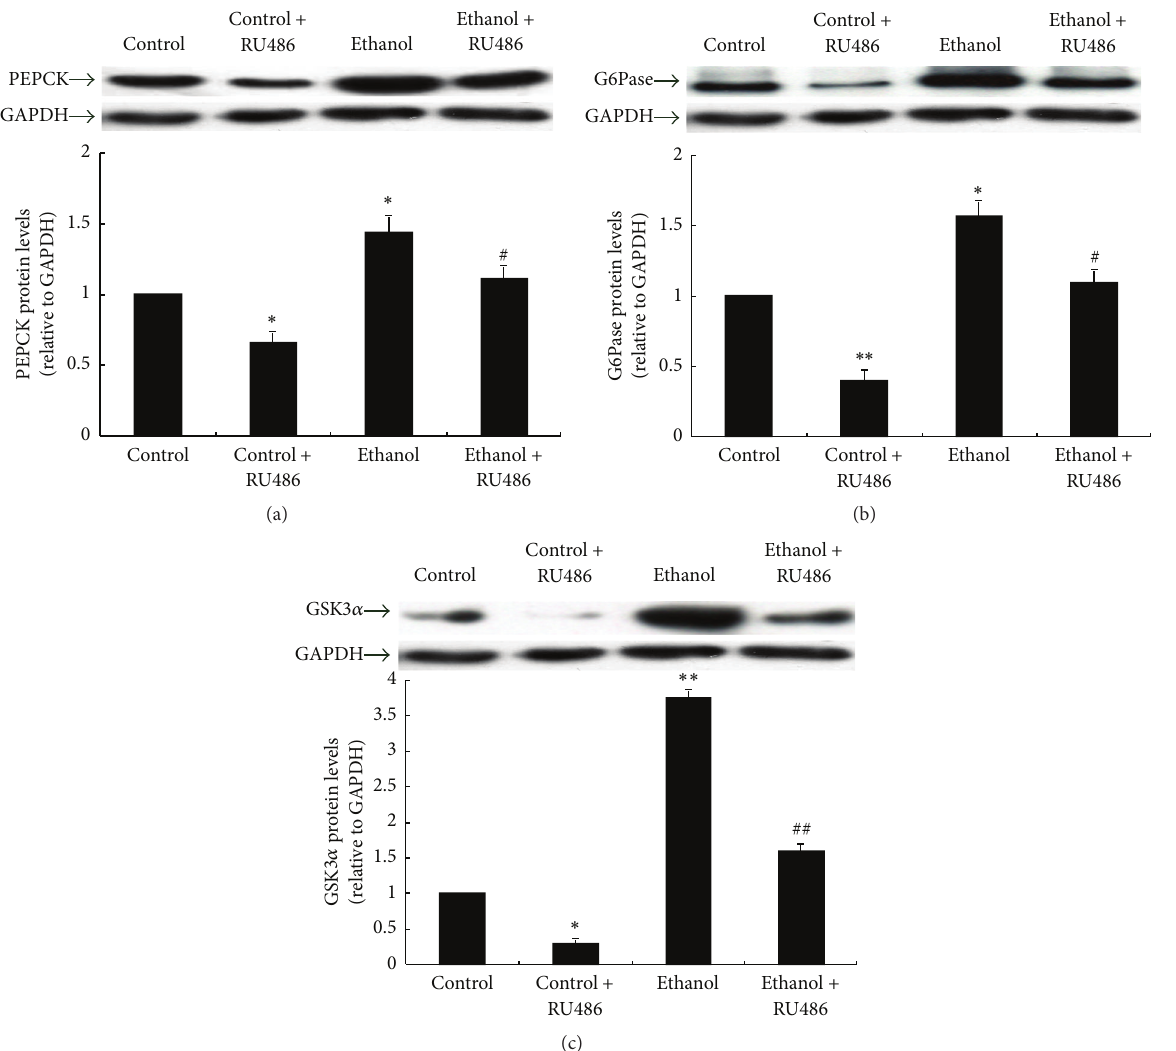
Figure 5: PEPCK, G6Pase, and GSK3 𝛼 proteins in Hepa 1–6 cells. Groups of cells were treated with 100mM ethanol and/or 10 𝜇 M RU486. Protein levels are expressed relative to the control and shown as the mean ± SEM. ( 𝑛 = 6 ). ∗ 𝑃 < 0.05 , ∗∗ 𝑃 < 0.01 versus control; # 𝑃 < 0.05 versus